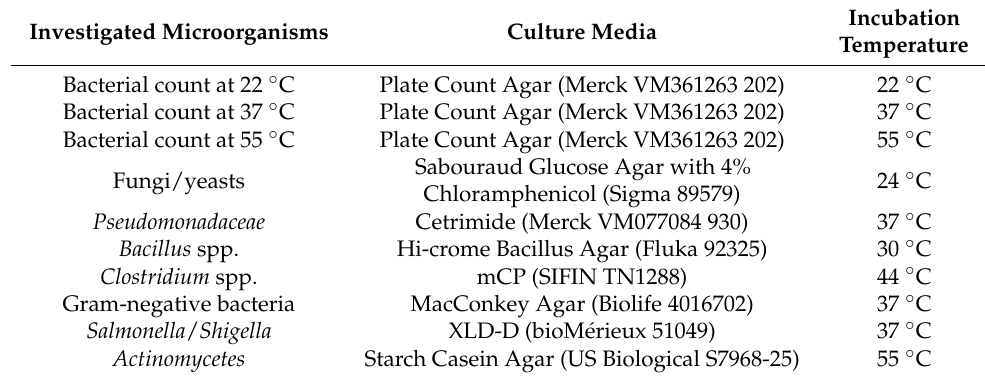
Table 1. Microorganisms investigated and technical information on culture media